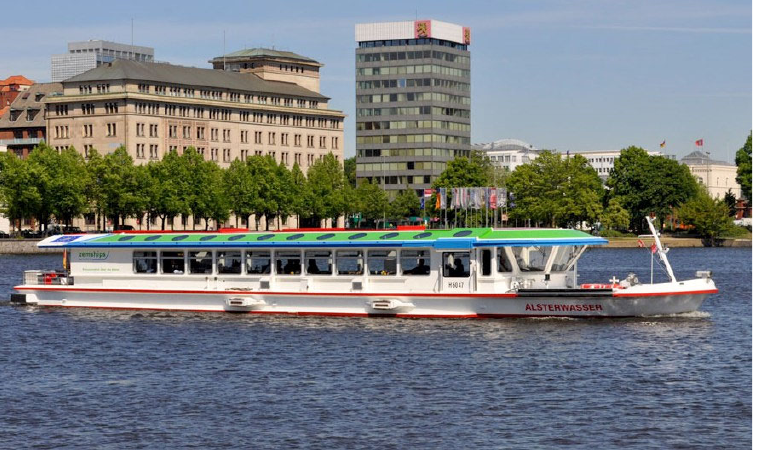
Figure 12. FCS Alsterwaser, operated on inner ‐ city waterways in Hamburg, Germany [100,101]. In 2012, Germanischer Lloyd approved design approaches for emissions ‐ free power generation with a mixed battery and fuel cell system using liquid hydrogen as a fuel. However, the long ‐ term viability of hydrogen production remains a significant concern [38].